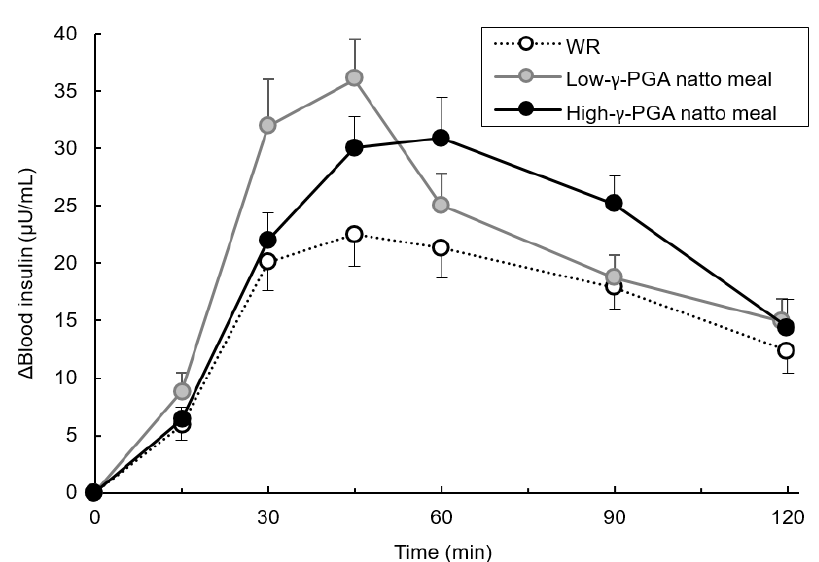
Figure 6. Changes in blood insulin levels over time following each test meal loading. The blood insulin elevation data from fasting to 15, 30, 45, 60, 90, and 120 min are shown as the mean ± the standard error (SE). WR: white rice; γ-PGA: gamma-polyglutamic acid.